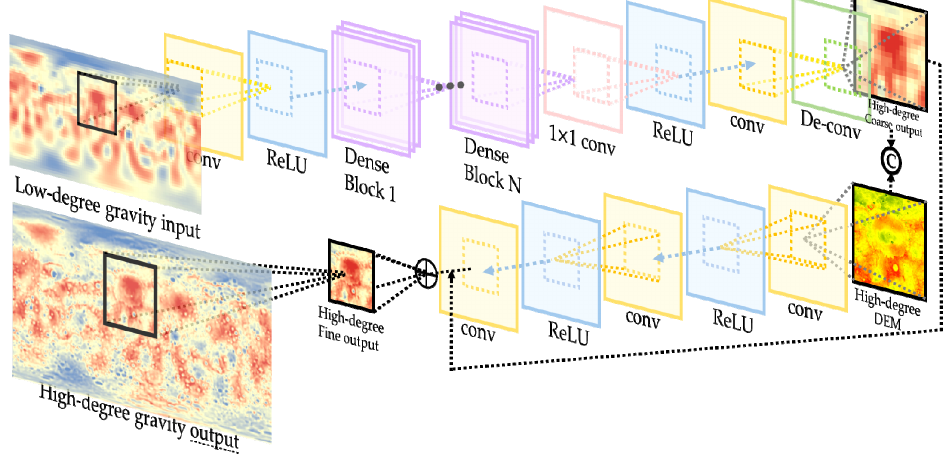
Figure 5. The structure of the proposed network. (The upper part is the gravity reconstruction network, and the lower part is the DEM refining network.).